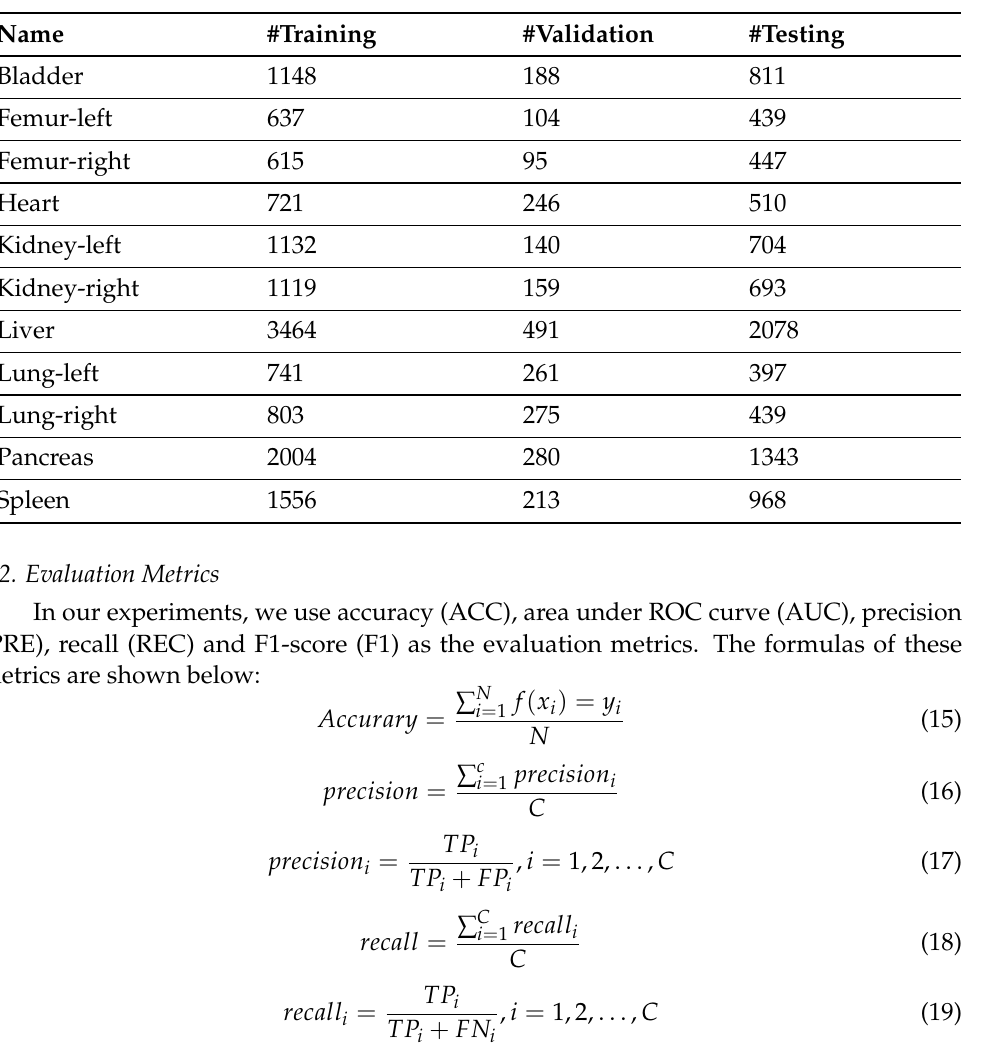
Table 8. Details of OrganMNIST_Sagittal